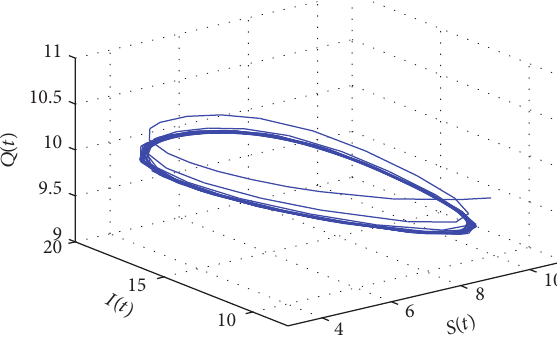
Figure 23: The phase plot of 𝑆 , 𝐼 , and 𝑄 when 𝜏 2 = 1.52 > 1.3485 = 𝜏 󸀠 20 and 𝜏 1 = 0.65 .